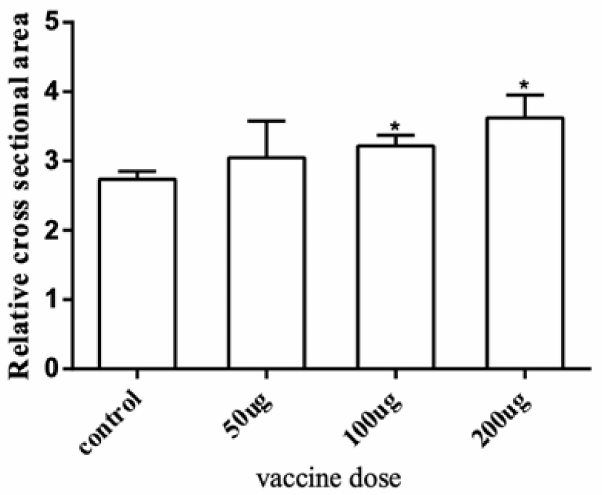
Figure 4. The average relative area of a single muscle fiber. The cross-section range of muscle fiber cells was accurately selected and the relative cross-sectional area of a single muscle fiber was calculated through Adobe Photoshop CS6 software. Bar: mean ± SE. * p < 0.05 unpaired t test, n =